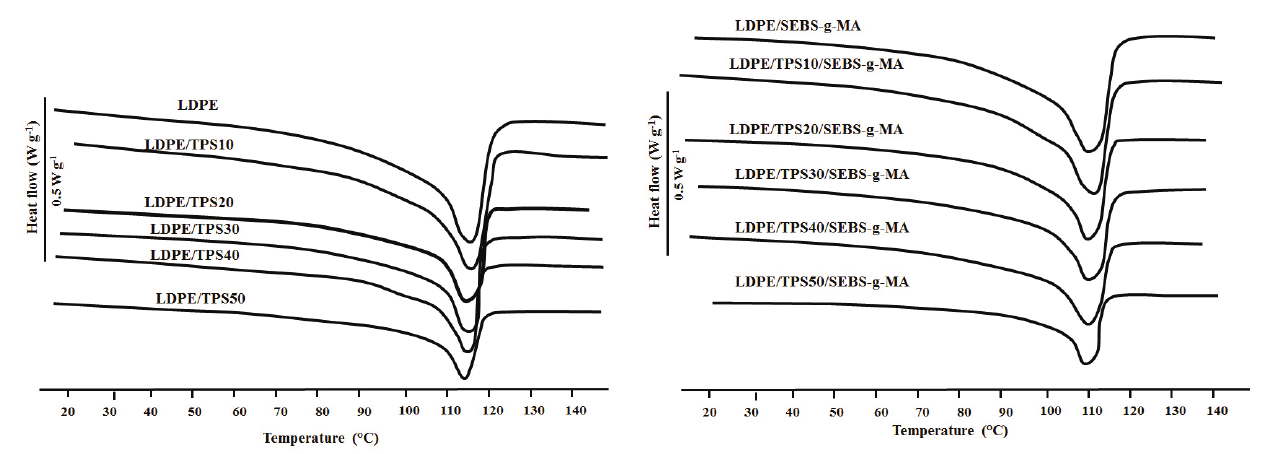
Fig. 4 – DSC heating thermograms of LDPE/TPS/SEBS-g- MA blends